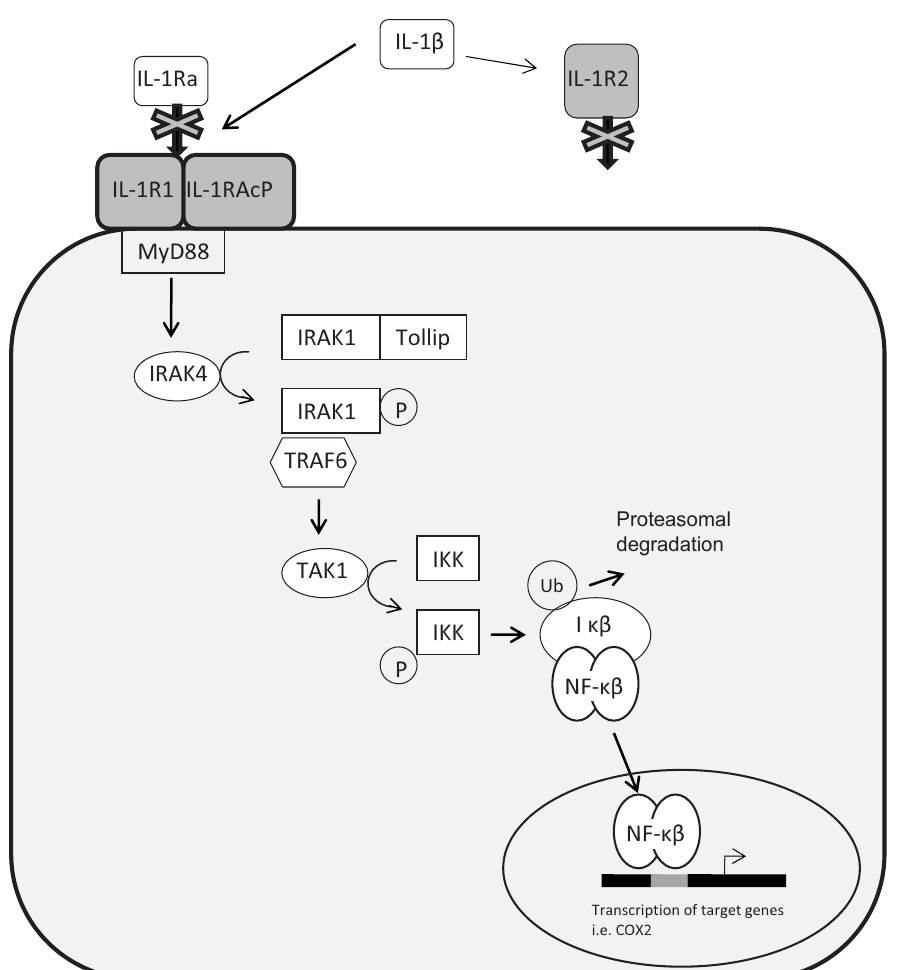
An overview of interleukin-1 NF- k B- dependent signalling. il-1 b binds to the il-1R1/il-1R1AcP heterodimer and the adapter protein myeloid differenti- ation primary response gene 88 (Myd88) is recruited to the complex [117].The bound Myd88 recruits il-1R- associated kinase-4 (iRAk4), which ini- tiates the recruitment ofToll-interact- ing protein (Tollip) / il-1R-associated kinase-1 (iRAk1) complexes [118]. iRAk4 phosphorylates iRAk1 and TNF-associated factor 6 (TRAF6) forms a complex with iRAk1 that subse- quently associates with and activates theTGF-activated kinase 1 (TAk1). dis-